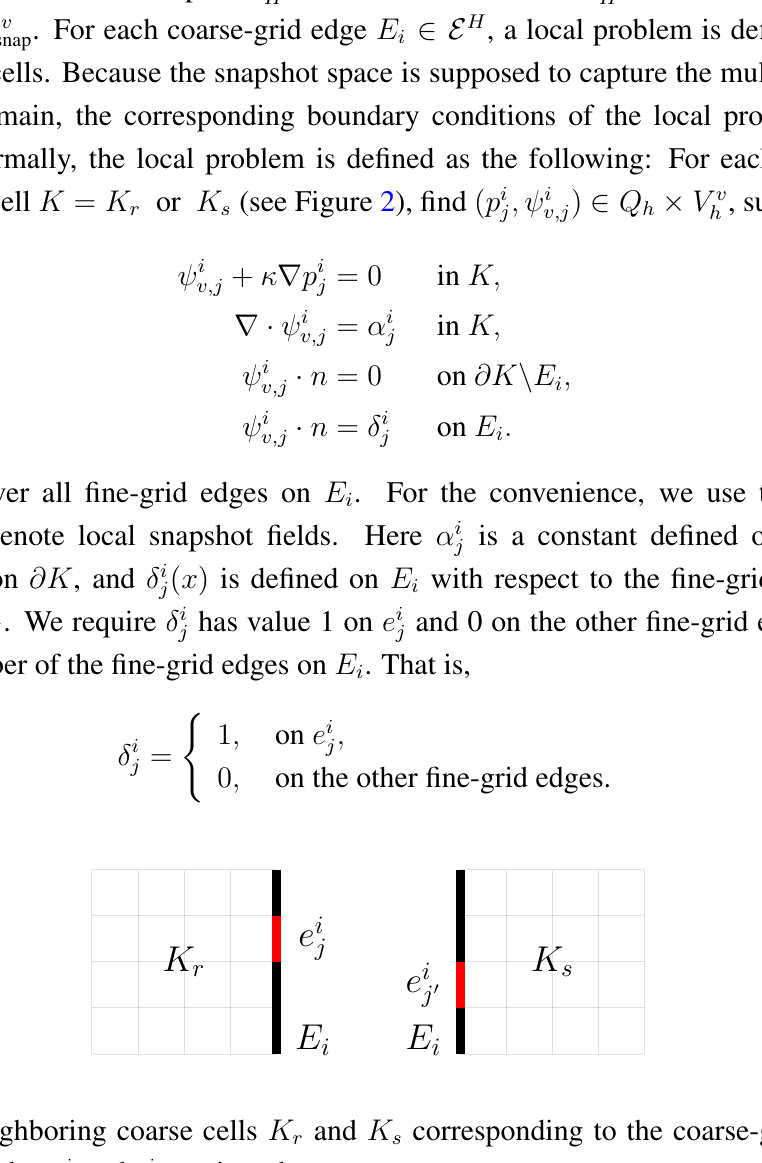
and K corresponding to the coarse-grid edge E r s